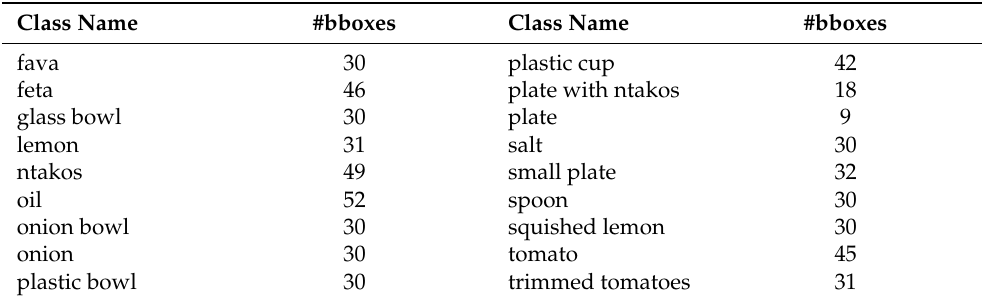
Figure 4. CVAT screens at various annotation stages. Each object was moved at various positions such that a variety of poses and locations was captured. Table 4. The number of bounding boxes that were annotated for each of the objects. Objects from both recipes are